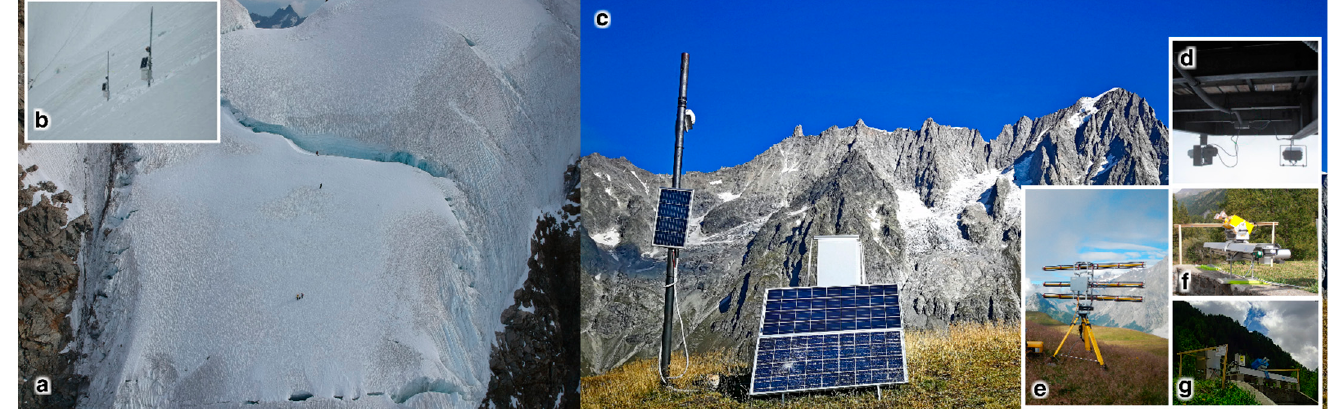
Figure 2. ( a ) Alpine guides install reflective prisms onto the Whymper Serac on 5 March 2020. ( b ) GNSS equipped with datalogger, solar panels, and batteries [46]. Reflective prisms were placed on the metallic bars that supported the GNSS for comparison. ( c ) TLC station that monitors the Montitaz Lobe, with the Planpincieux and Grandes Jorasses glaciers visible in the background. ( d ) TLC station that monitors the Whymper Serac from Pointe Helbronner. ( e – g ) the RAR GPRI and the GBSARs IBIS ‐ L and FastGBSAR, respectively.